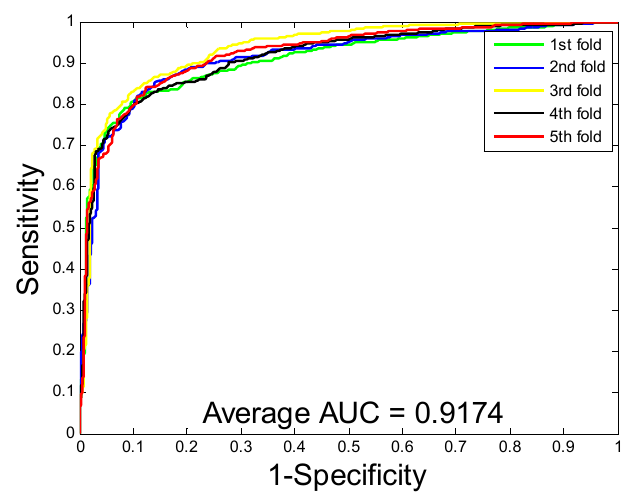
Figure 5. The ROC curves are generated by the support vector machine (SVM) classifier on enzyme dataset.